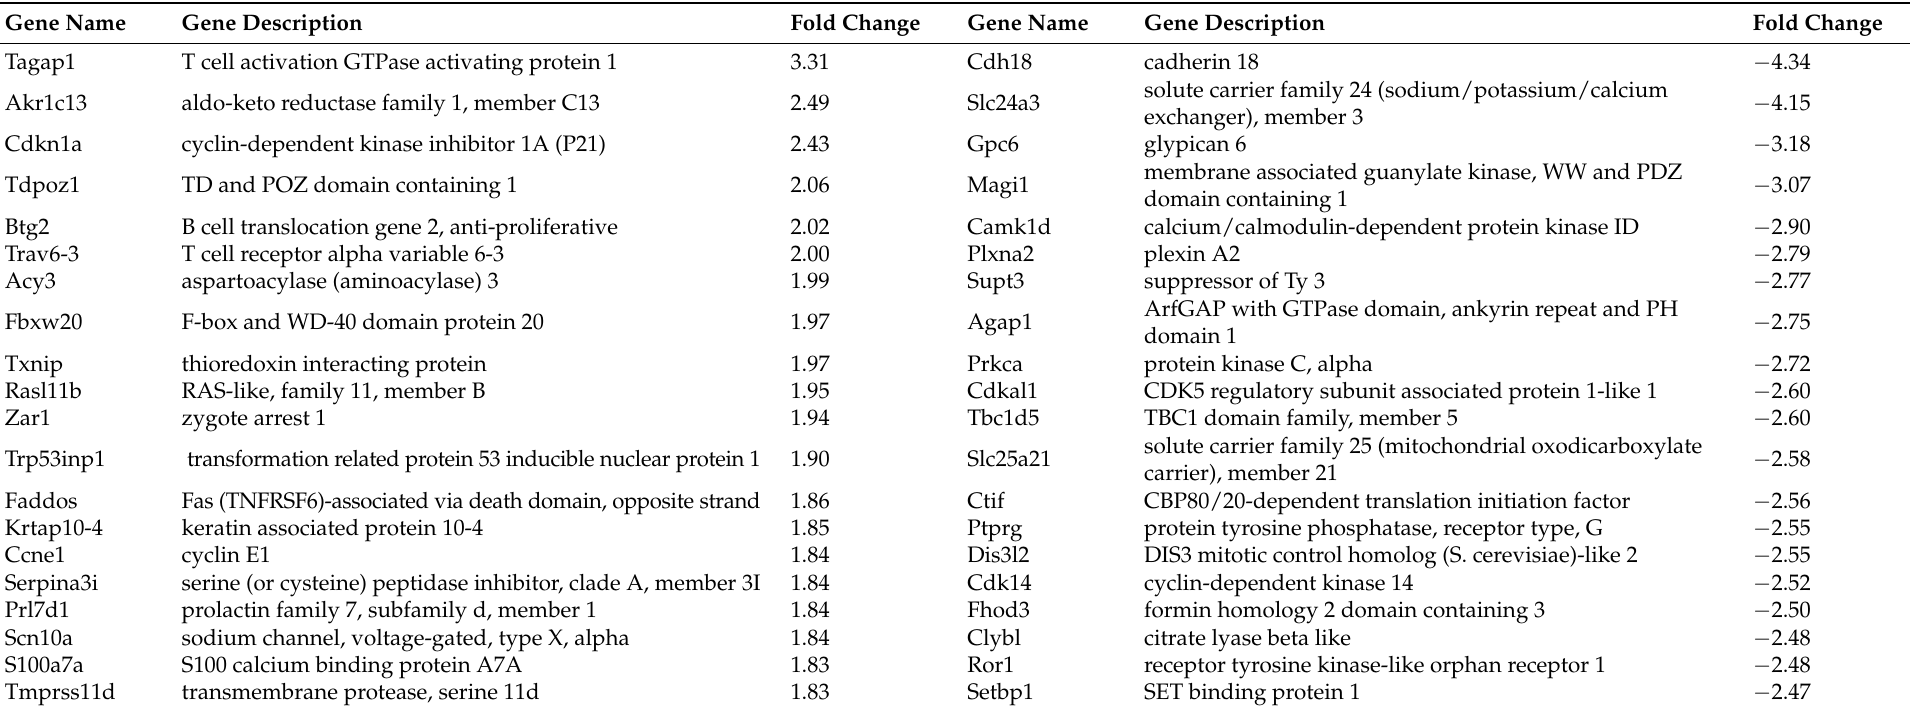
Table 4. List of top 20 up and downregulated genes in 24 h metformin-pretreated